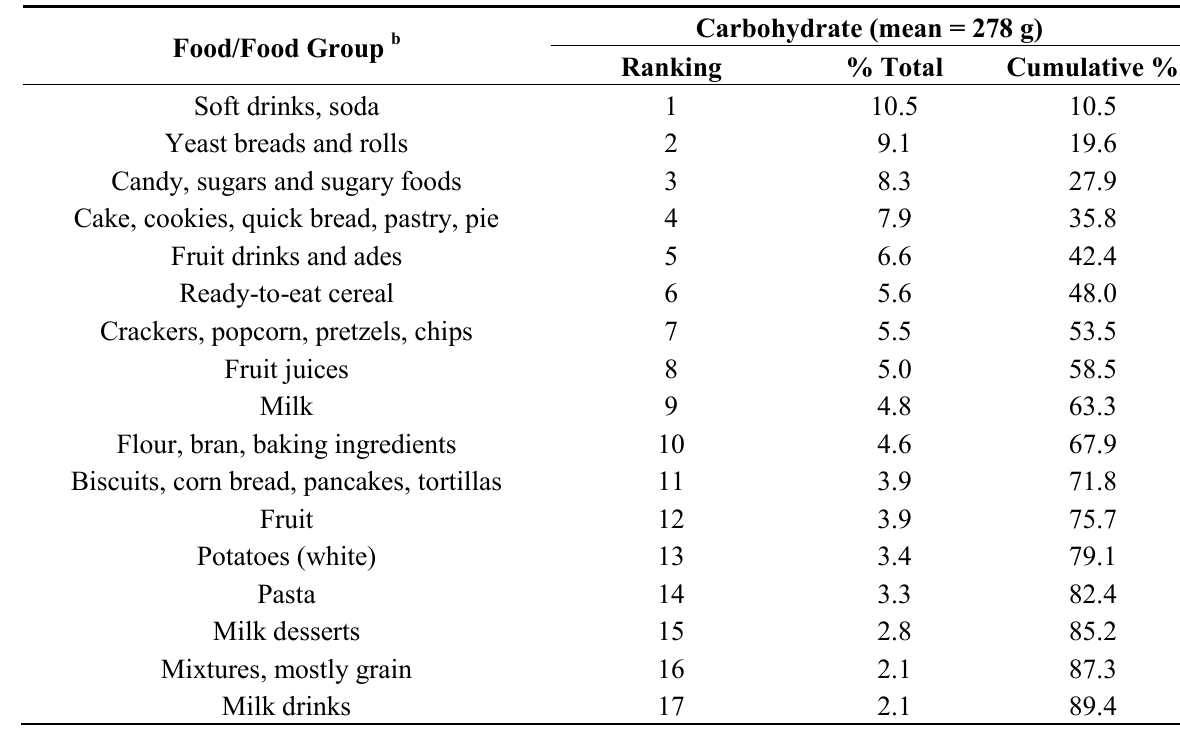
Table 3. Food/Food group sources of carbohydrate among US children aged 2–18 years (from NHANES 2003–2006) a .